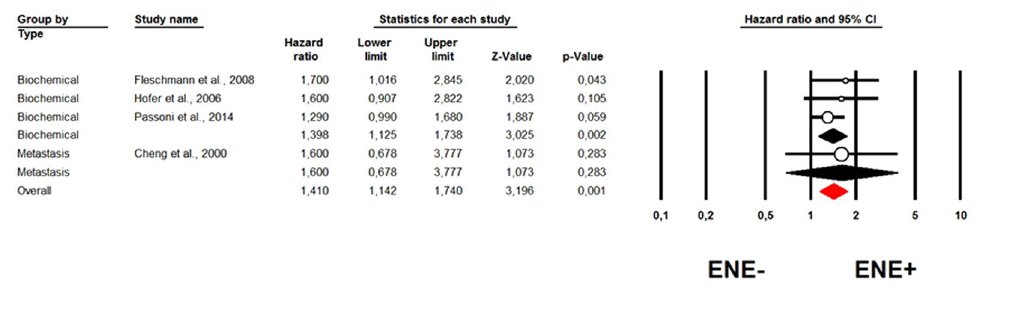
Figure 3. Forrest plot for hazard ratios (HRs) for recurrence (adjusted for potential confounders) by extranodal extension status. We present data in the same manner used for Fig. 2. The only difference is that there is an additional paper (Hofer et al .) for the risk biochemical